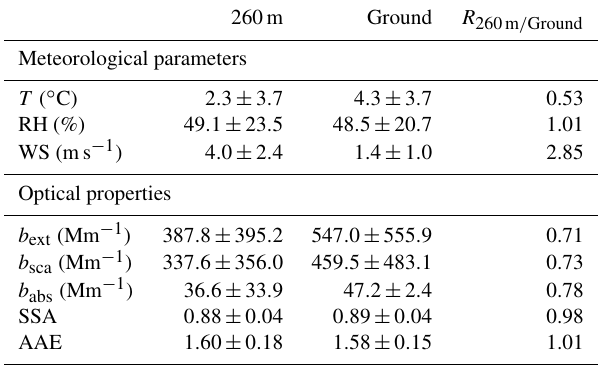
Table 2. A summary of average ( ± 1 σ ) meteorological parameters and optical properties at ground level and 260m during this study. 260m Ground R 260m /